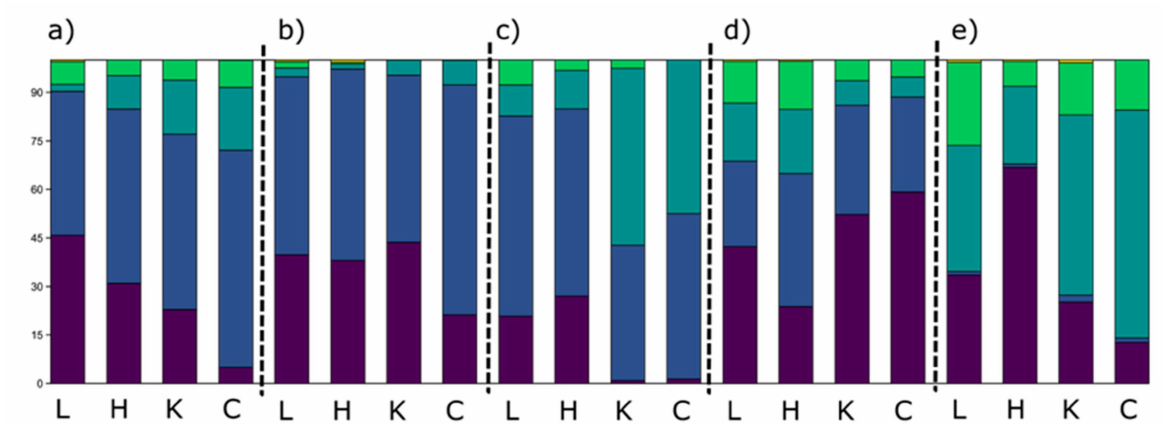
Figure 5. Percentages of different terpene classes in studied Satureja EOs from leaves, herba, calyx, and corolla. ( a ) S. montana subsp. montana from the mountain region; ( b ) S. montana subsp. montana from the coastal region; ( c ) S. kitaibelii ; ( d ) S. sub- spicata subsp. liburnica ; ( e ) S. subspicata subsp. subspicata ; : Monoterpene hydrocarbons; : Oxygenated